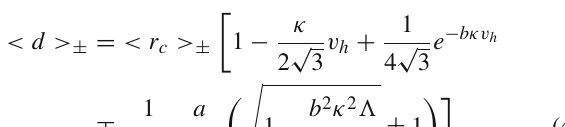
Fig. 3 V F ( R ) vs d ( t ) − 1 ,κv